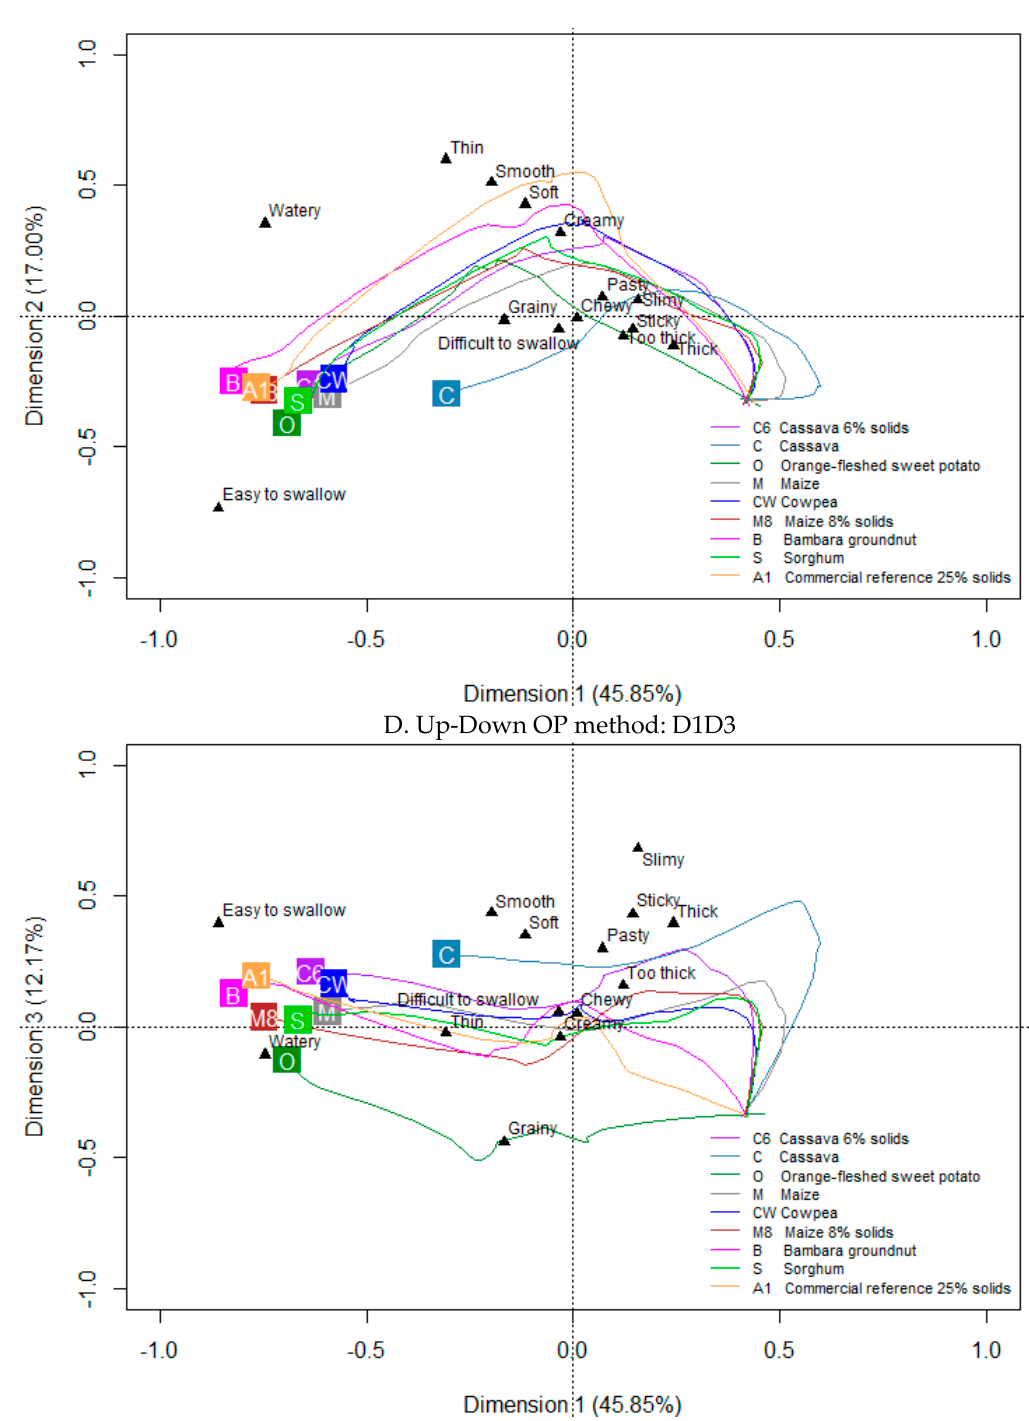
Figure 2. Smoothed Principal Component Analysis (PCA) product trajectory biplots show the evolution of attributes during oral processing for nine complimentary porridges (CPs) at 10% solids unless otherwise specified.